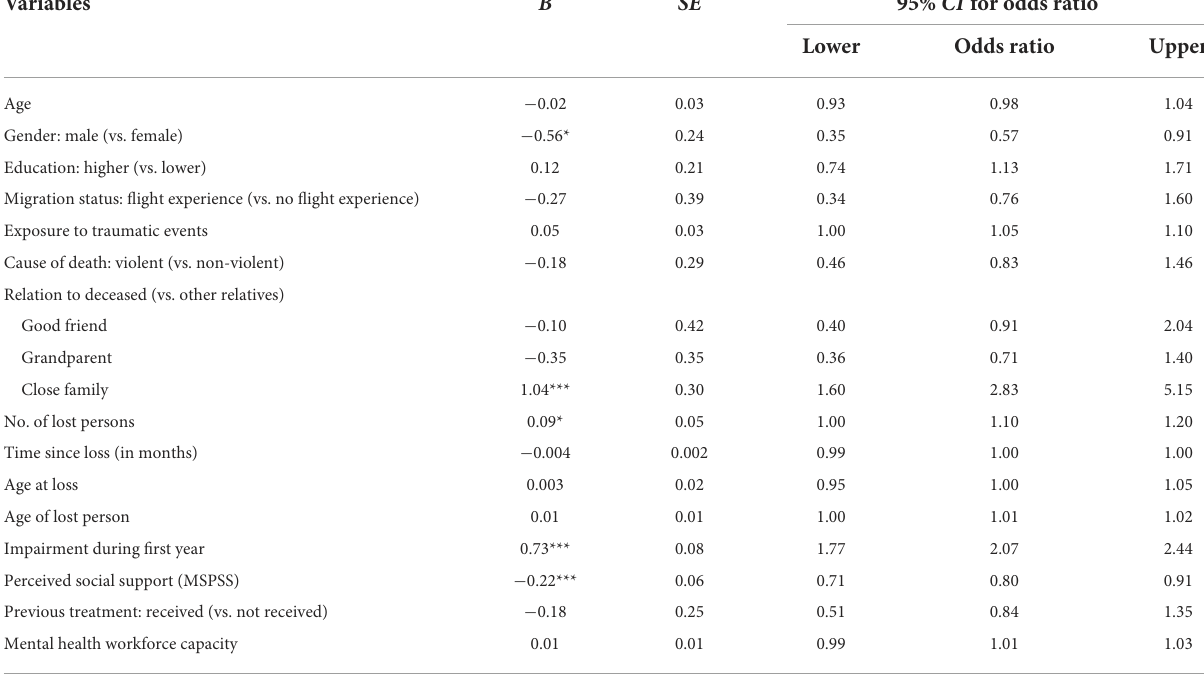
TABLE 4 Results of the logistic regression of demographic, loss-, trauma-, and support-related variables on PGD according to ICD-11. Variables